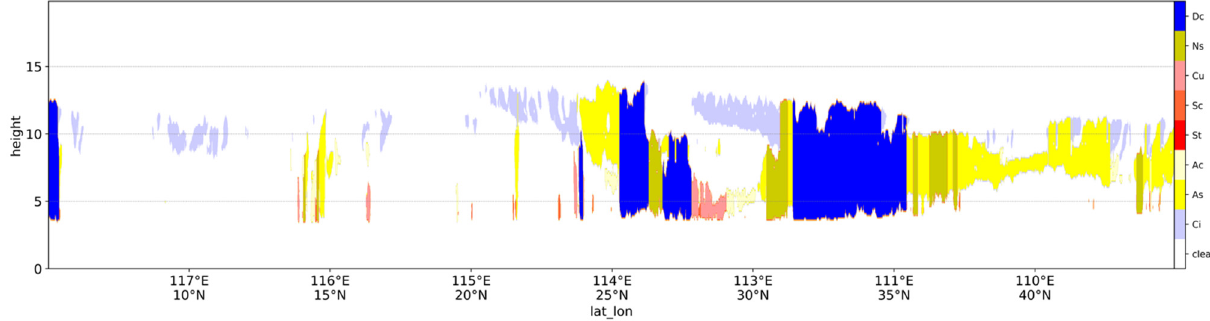
Figure 3. Visualization of cloud type variables in the CloudSat satellite 2B-CLDCLASS (Example time 20190708).